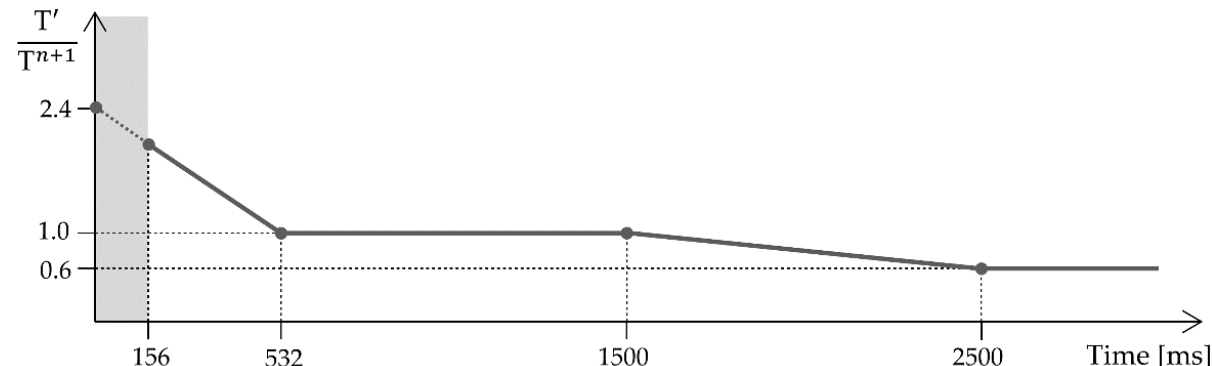
Figure 7. Decreasing dynamic of the detection threshold. At time = 0, a QRS detection has just occurred. Initially, the threshold T (cid:48) decreases from 2.4 T n + 1 to T n + 1 . During the refractory period, portrayed by the gray area, no detection is registered. As the time elapsed without a detection increases, T (cid:48) decreases from T n + 1 to 0.6 T n + 1 , then plateaus again.